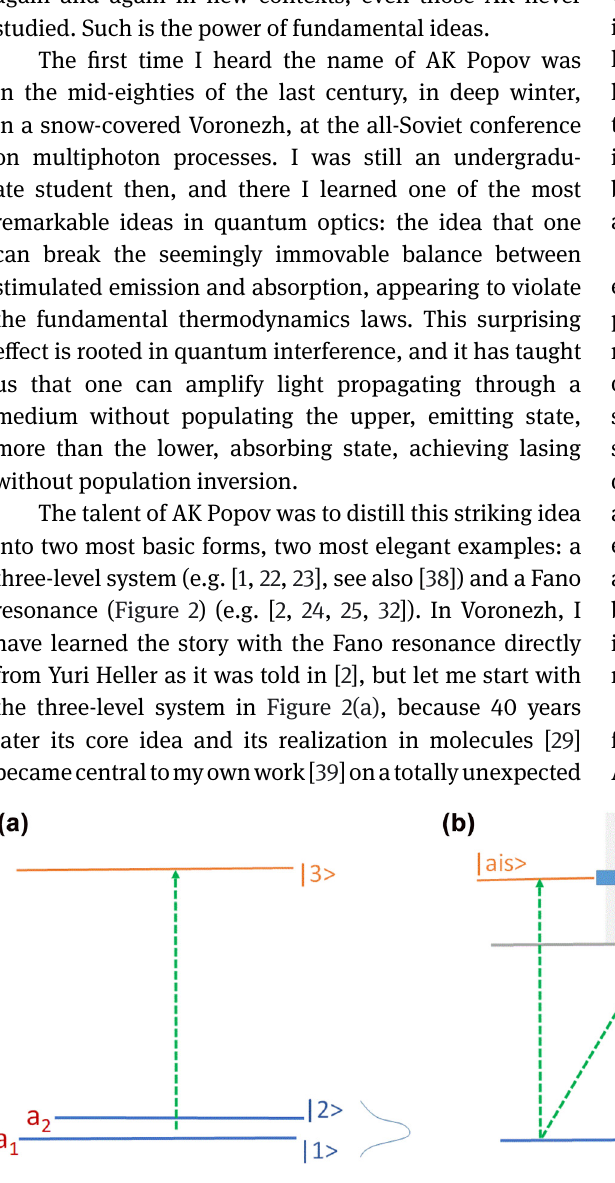
Figure 2: Two basic schemes breaking the balance between stimulated emission and absorption, leading to lasing without population inversion. Panel (a): Coherent superposition of two lower states can lead to destructive interference in absorption when the relative phase between the transitions from them is 180 ◦ . Panel (b): Interference of the two pathways to the continuum state | k ⟩ , directly along the diagonal and indirectly via | ais ⟩ can also be destructive, suppressing absorption from the state | 1 ⟩ but not the emission from the | ais ⟩ to | 1 ⟩